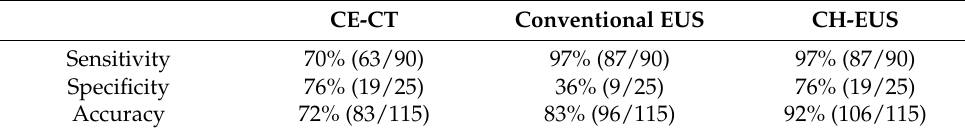
Table 2. Detection Abilities for Mural Nodules on CE-CT, EUS, and CH-EUS. CE-CT Conventional